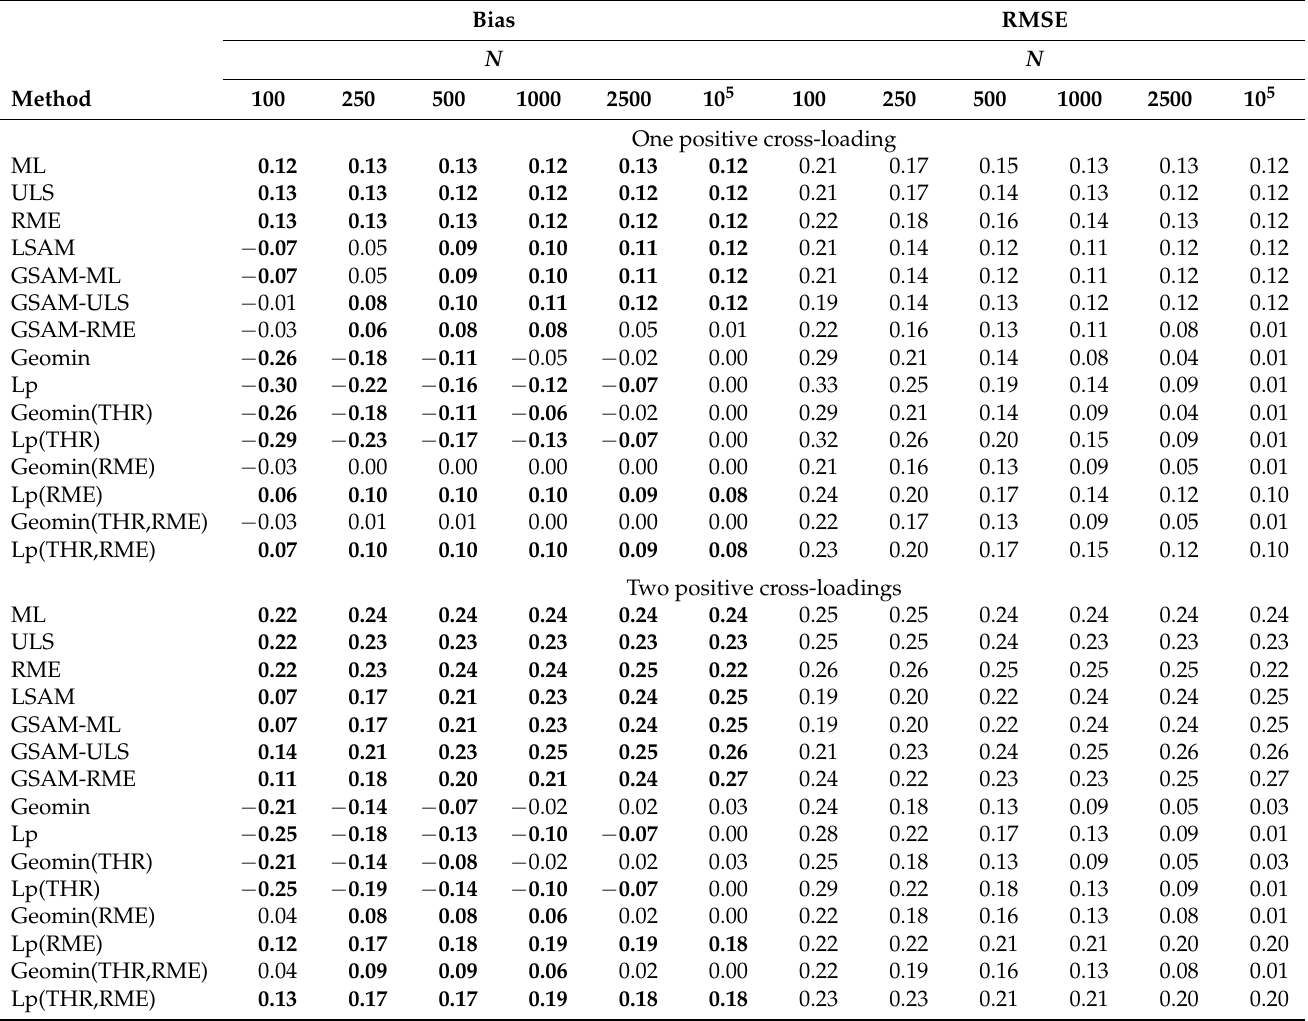
Table 6. Simulation Study 2 (two factors and cross loadings): bias and root mean square error (RMSE) of estimated factor correlation as a function of sample size with one and two positive cross loadings in the data-generating